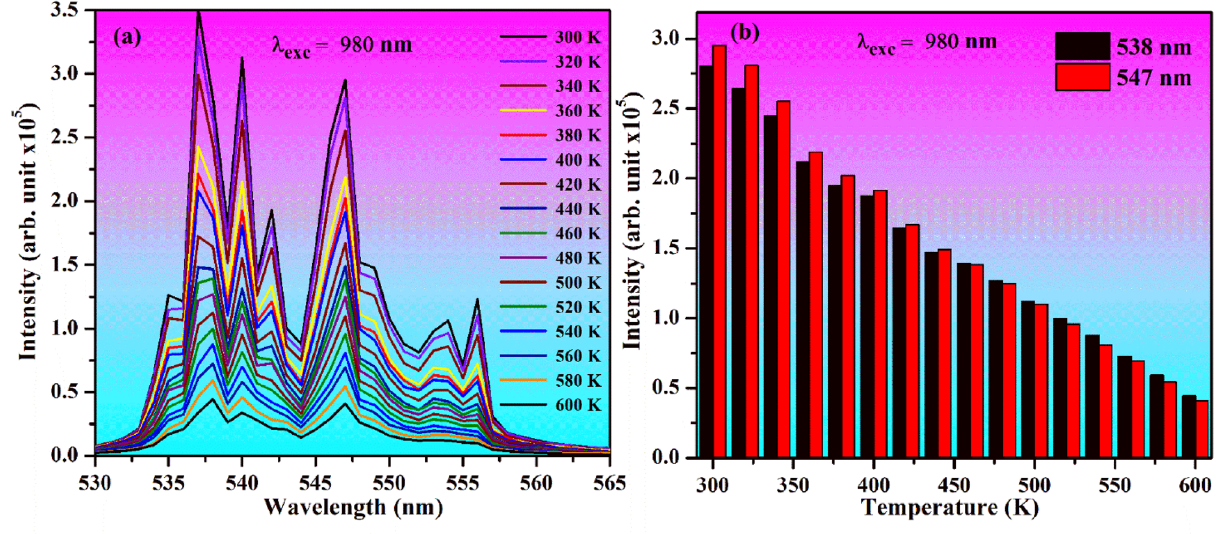
Figure 12. ( a ) Temperature dependent UC spectra of Ho 3+ /Yb 3+ /5Bi 3+ co-doped ZnGa 2 O 4 sample under 980 nm excitations at 12.73 W/cm 2 . ( b ) Variation in emission intensity of the two TCLs at 538 and 547 nm monitored at various